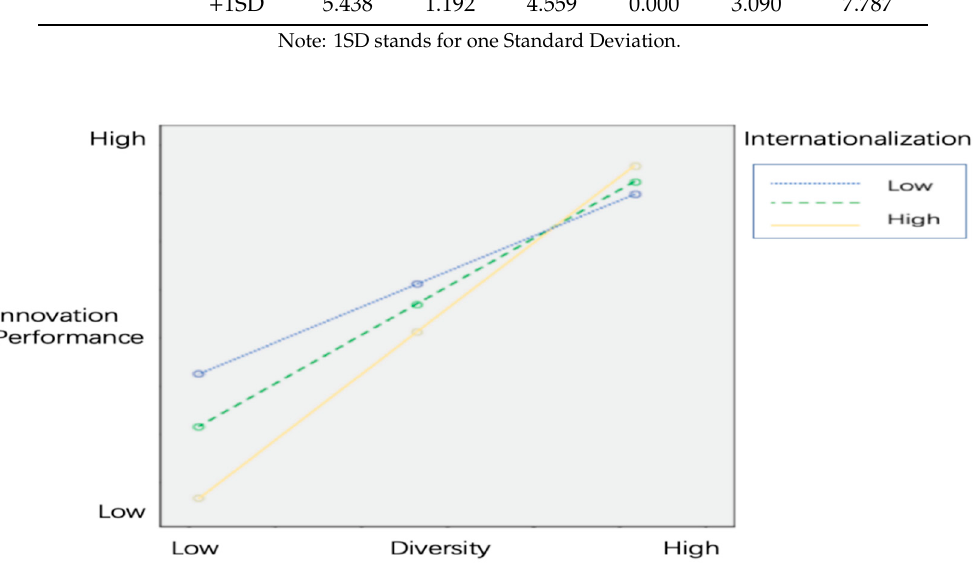
Figure 2. The interaction between TMT age diversity and internationalization.